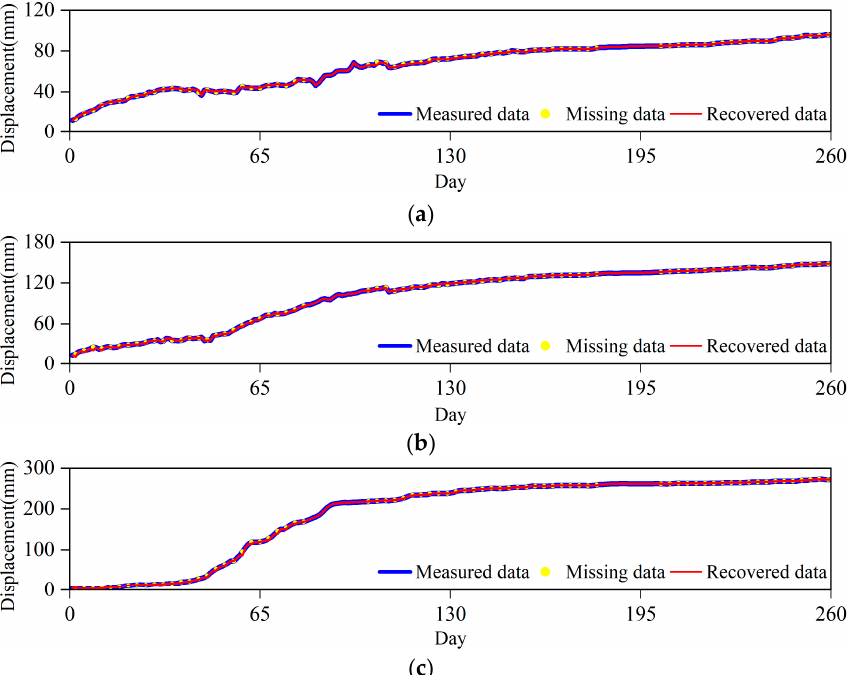
Figure 5. Completion of displacement data (NM40%). ( a ) Point SZY-02; ( b ) point SZY-03; ( c ) point SZY-06. The blue curve represents the measured data, the yellow dots represent the missing data and the red curve represents the recovered data.